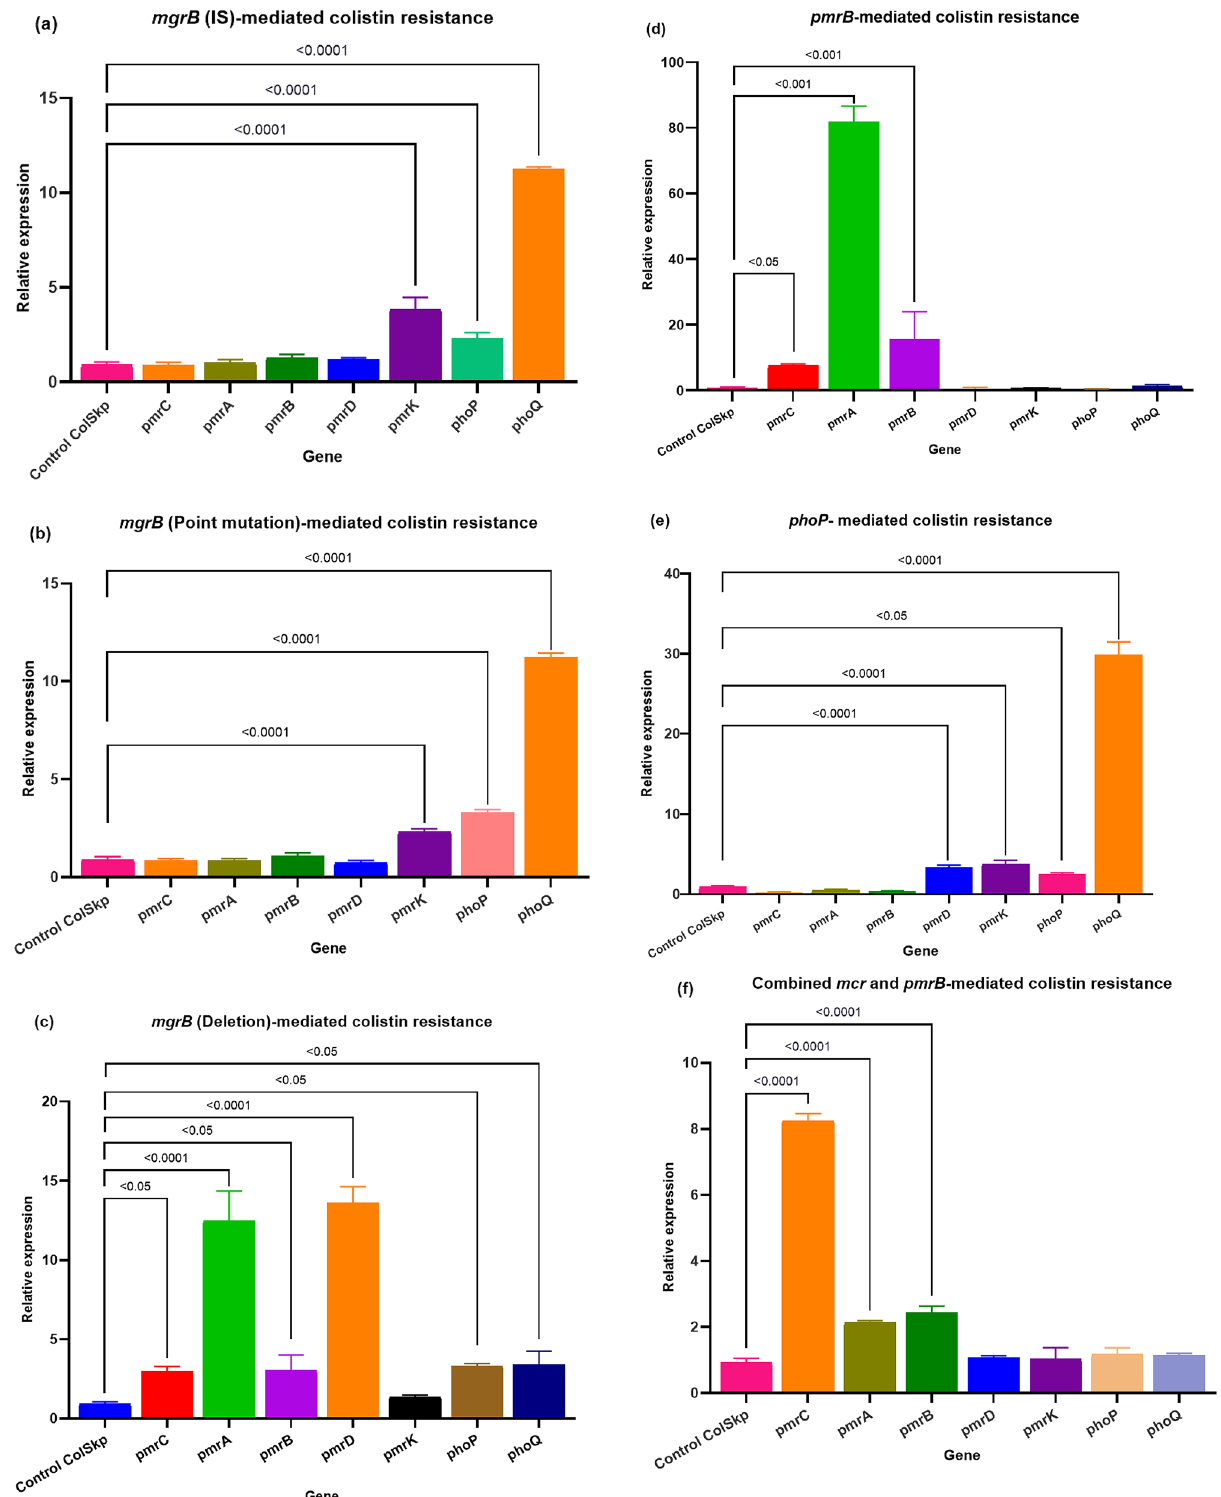
Figure 3. Expressions of LPS modification genes among ( a ) ColRkp with IS 1-like integration in mgrB , ( b ) ColRkp with G60A mgrB , ( c ) ColRkp with deleted mgrB , ( d ) ColRkp with T157P PmrB, ( e ) ColRkp with E82K PhoP, and ( f ) ColRkp with combined presence of mcr-8.1 and R256G